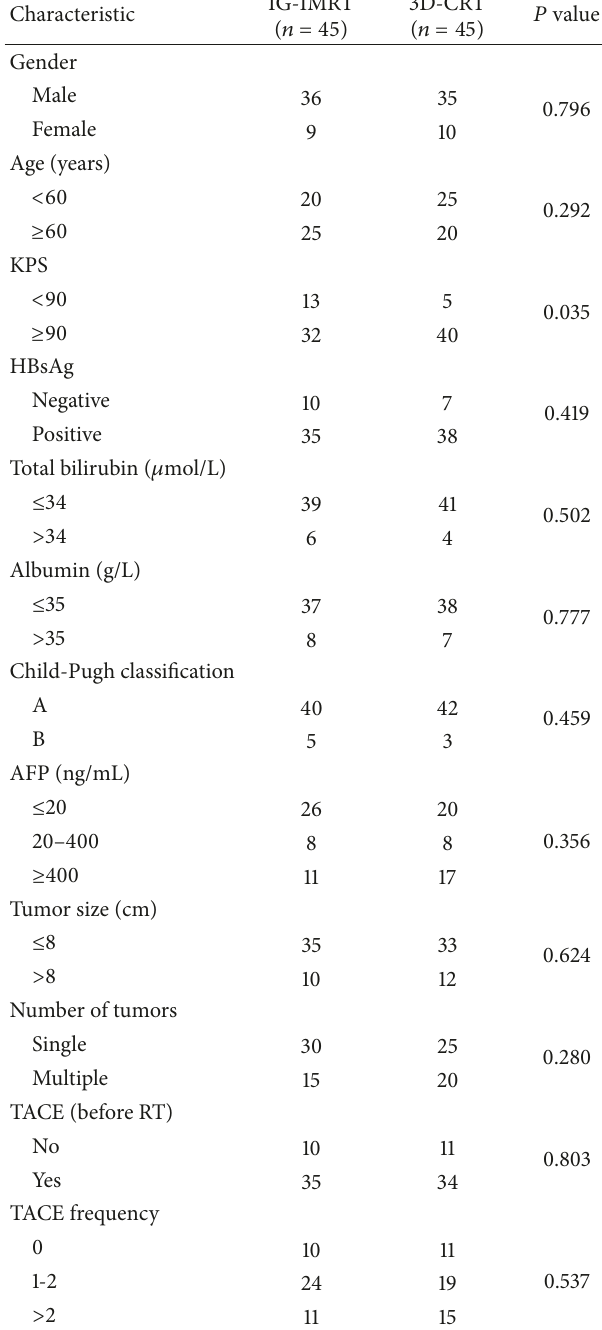
Table 1: Patient